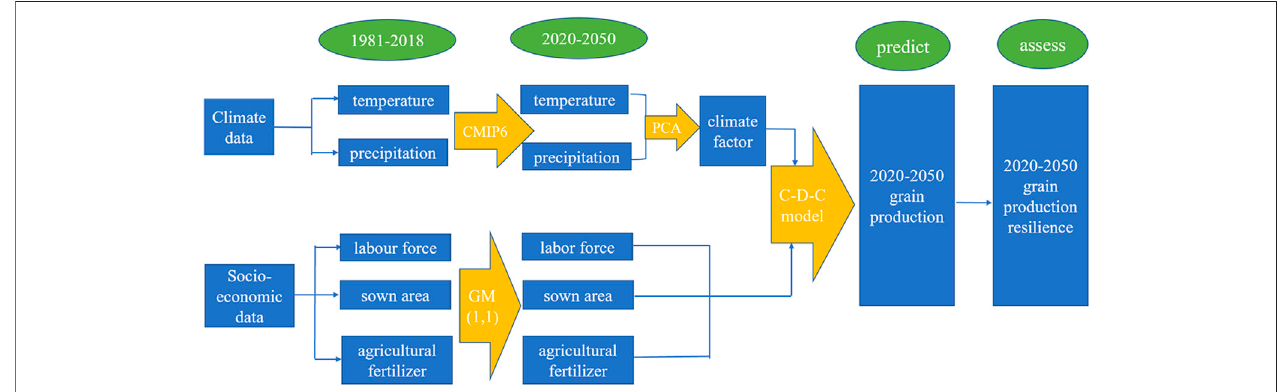
FIGURE 2 | Flow chart of China ’ s grain yield resilience under global climate